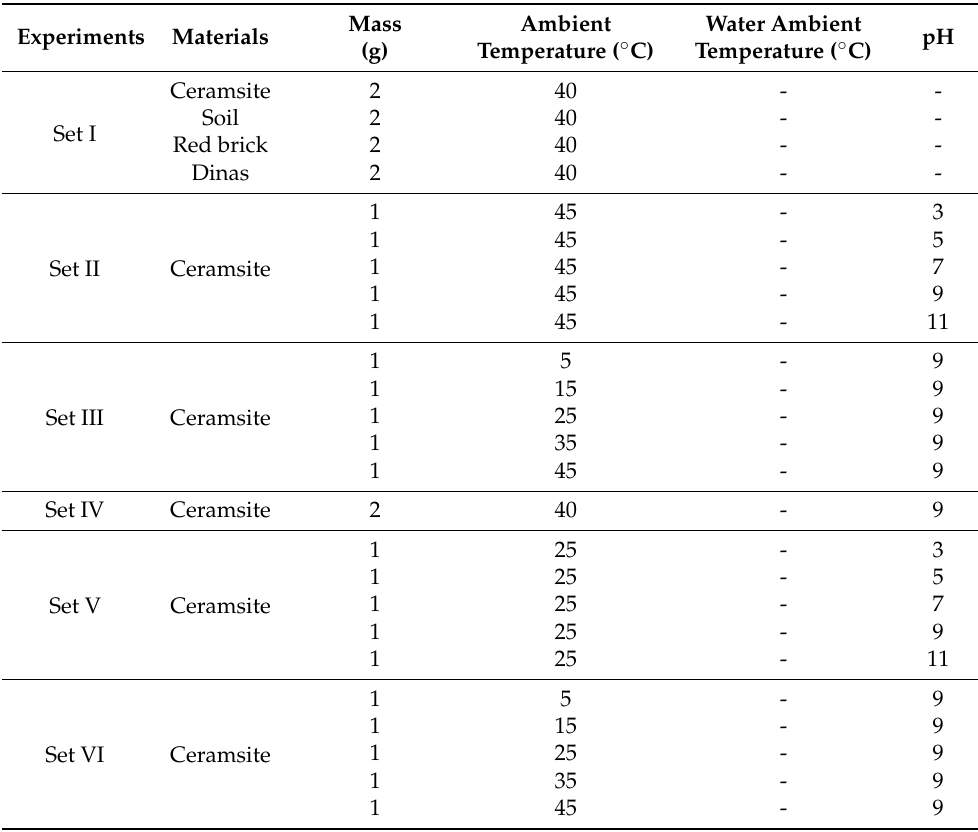
Table 3. Set table of experimental scheme of ceramsite